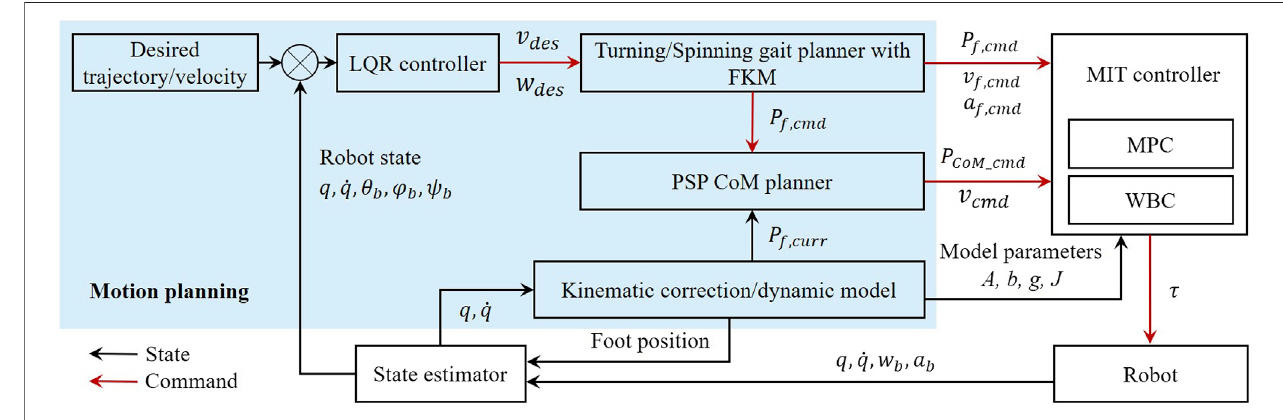
FIGURE 1 | The control framework for the terrain-perception-free and accurate spinning movement of quadruped locomotion. The blue region highlights the work proposed in this study. MIT Mini Cheetah tracking controller functions as the low-level motion controller. A state estimator provides state measurements for the kinematics correction, LQR controller, and CoM trajectory planner. q and _ q are the joint position and velocity, respectively. The robot states θ b , φ b , and ψ b are the roll, pitch, and yaw angular of the body. ω b , a b are the angular velocities and linear accelerations of the body. The foot states P f ,cmd , v f ,cmd , and a f ,cmd are the position, velocity, and acceleration commands, respectively. P f ,cmd , v f ,cmd , ω b , and a b are elements of R 3 N × 1 , where N is the number of foot contact on the ground.